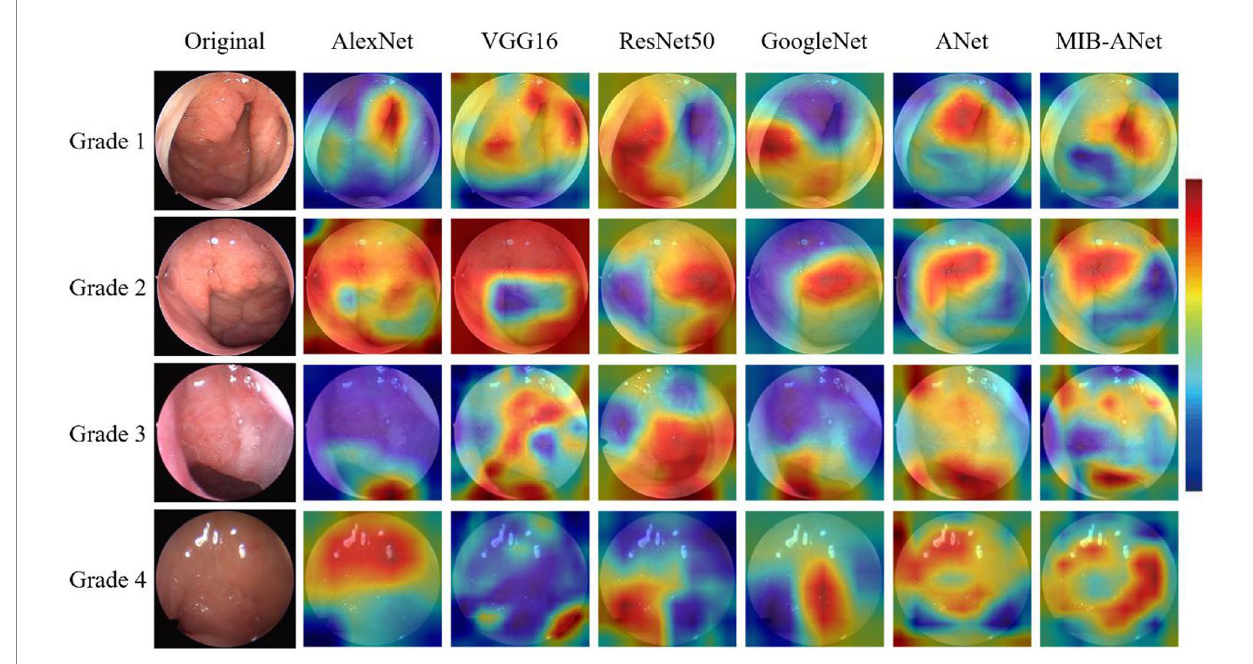
FIGURE 5 The heatmaps of different deep networks for adenoid hypertrophy prediction. The first column shows the original adenoid images. The second, third, fourth, fifth, sixth, and seventh columns show the heatmaps of AlexNet, VGG16, ResNet50, GoogleNet, ANet and MIB-ANet, respectively.